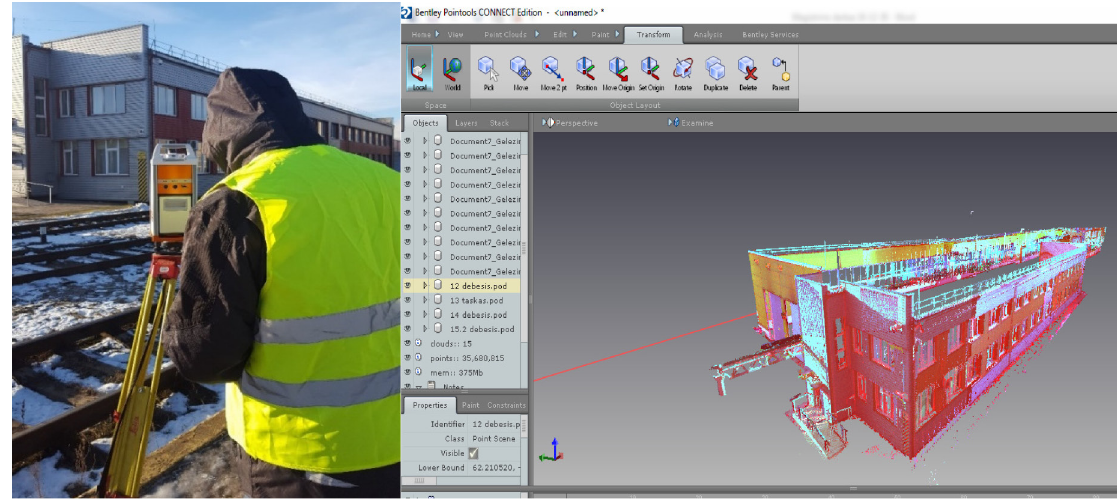
Fig. 3. BIM uses in reconstruction project: a Lithuanian case study (laser scan and